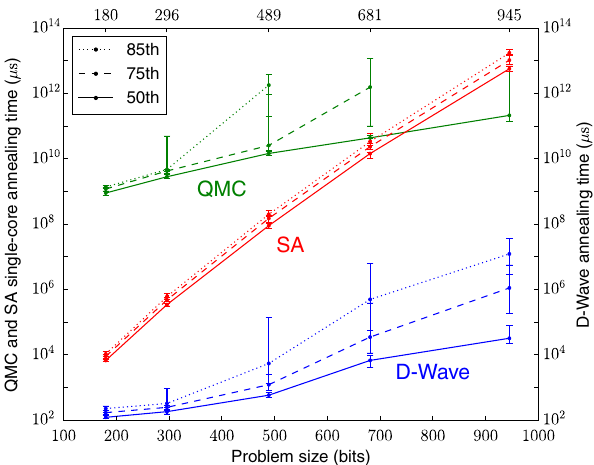
FIG. 4. Time to find the optimal solution with 99% probability for different problem sizes. We compare simulated annealing (SA), the quantum Monte Carlo (QMC) method, and the D-Wave 2X. To assign a runtime for the classical algorithms we take the number of spin updates (for SA) or worldline updates (for QMC method) that are required to reach a 99% success probability and multiply that with the time to perform one update on a single state-of-the-art core. Shown are the 50th, 75th, and 85th per- centiles over a set of 100 instances. The error bars represent 95% confidence intervals from bootstrapping. This experiment occupied millions of processor cores for several days to tune and run the classical algorithms for these benchmarks. The runtimes for the higher quantiles for the larger problem sizes for the QMC algorithm were not computed because the computational cost was too high. For a similar comparison with the QMC method with different parameters, please see Fig.